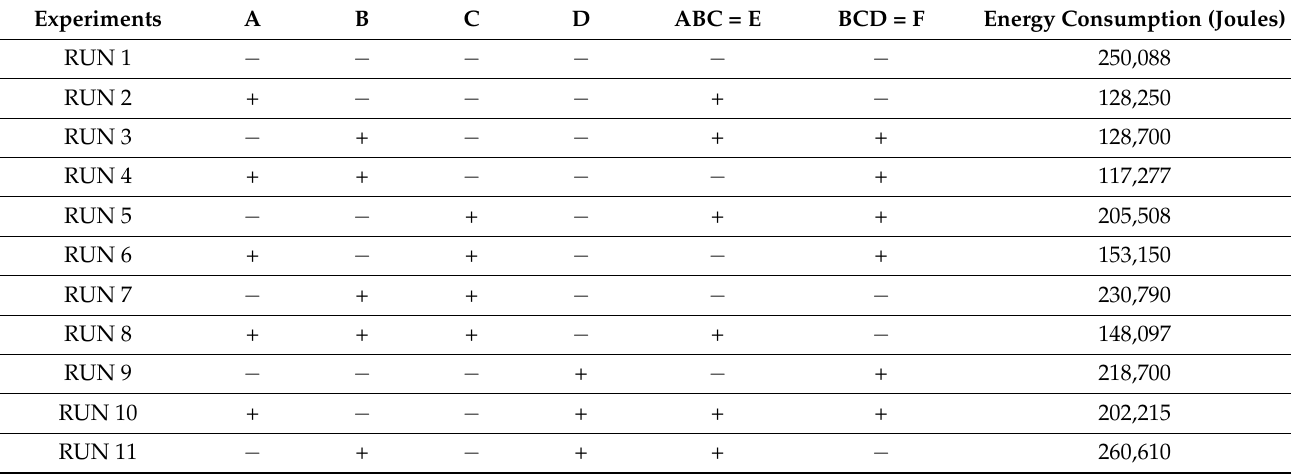
Table 2. Recommended 2-level fractional factorial design with measured energy